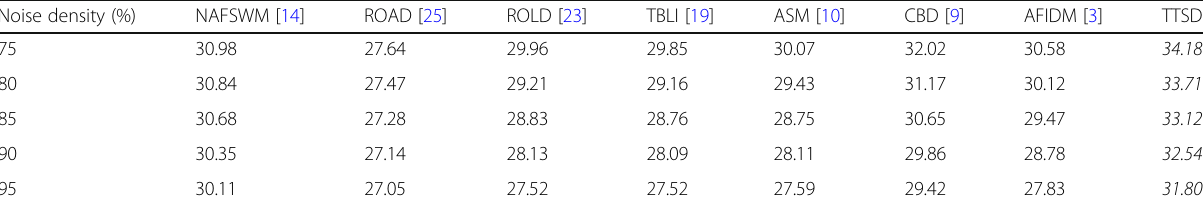
Table 4 Restoration results in average PSNR (dB) for TID2008 database corrupted by RVIN Noise density